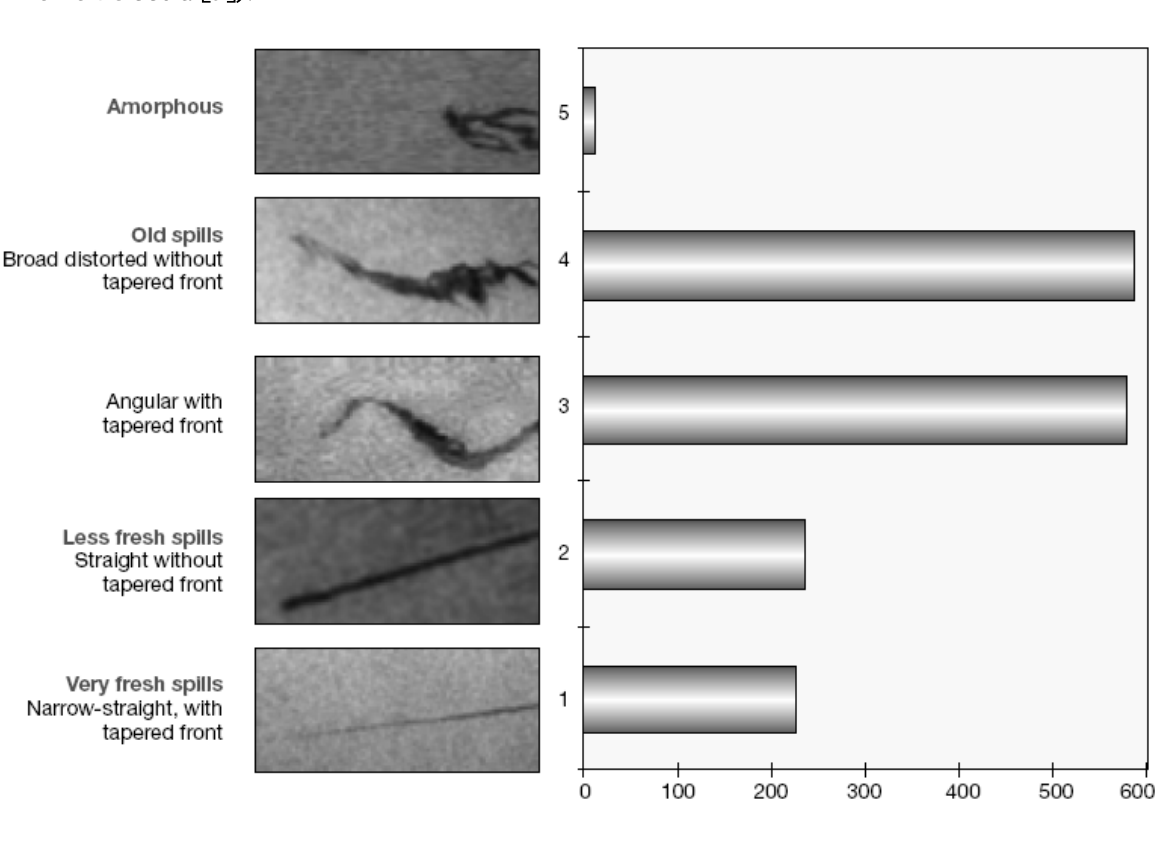
Figure 2. Classification of 1638 detected oil spills in terms of their shapes (adapted from Pavlakis et al.